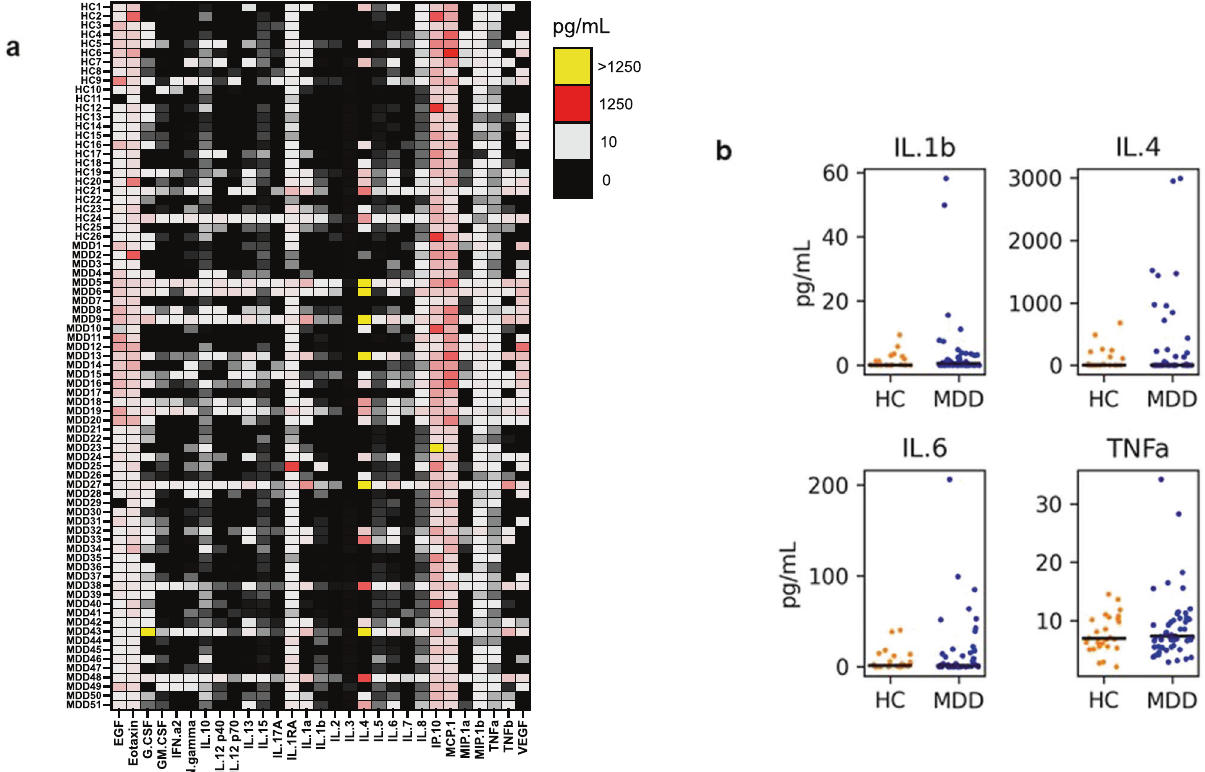
Fig. 2 Baseline circulating cytokine pro fi les in individuals with major depressive disorder (MDD) vs. healthy controls (HC). a Heat map of cytokine pro fi les. Rows show the data for each individual (subject number, disease grouping), columns show each analyte. Interpolated assay values (picogram/milliliter; pg/mL) are heat mapped, with black denoting the lowest values. EGF epidermal growth factor, G-CSF granulocyte colony-stimulating factor, GM-CSF granulocyte-macrophage colony-stimulating factor, IFN interferon, IL interleukin, IP-10 interferon-gamma induced protein 10 (CXCL10); MCP1 monocyte chemoattractant protein 1, MIP-1 α macrophage in fl ammatory protein 1a (CCL3), MIP-1 β macrophage in fl ammatory protein 1b (CCL4), TNF tumor necrosis factor, VEGF vascular endothelial growth factor. MDD major depressive disorder, HC healthy control. b Comparison of selected cytokine levels in MDD (blue) vs. HC (orange). The black horizontal line denotes median values for each analyte and cohort. The sample size is n = 51 MDD and n = 26 HC. No differences were signi fi cant by a Wilcoxon rank-sum test in any of the 29 analytes (all comparisons are shown in Fig. S1, p >